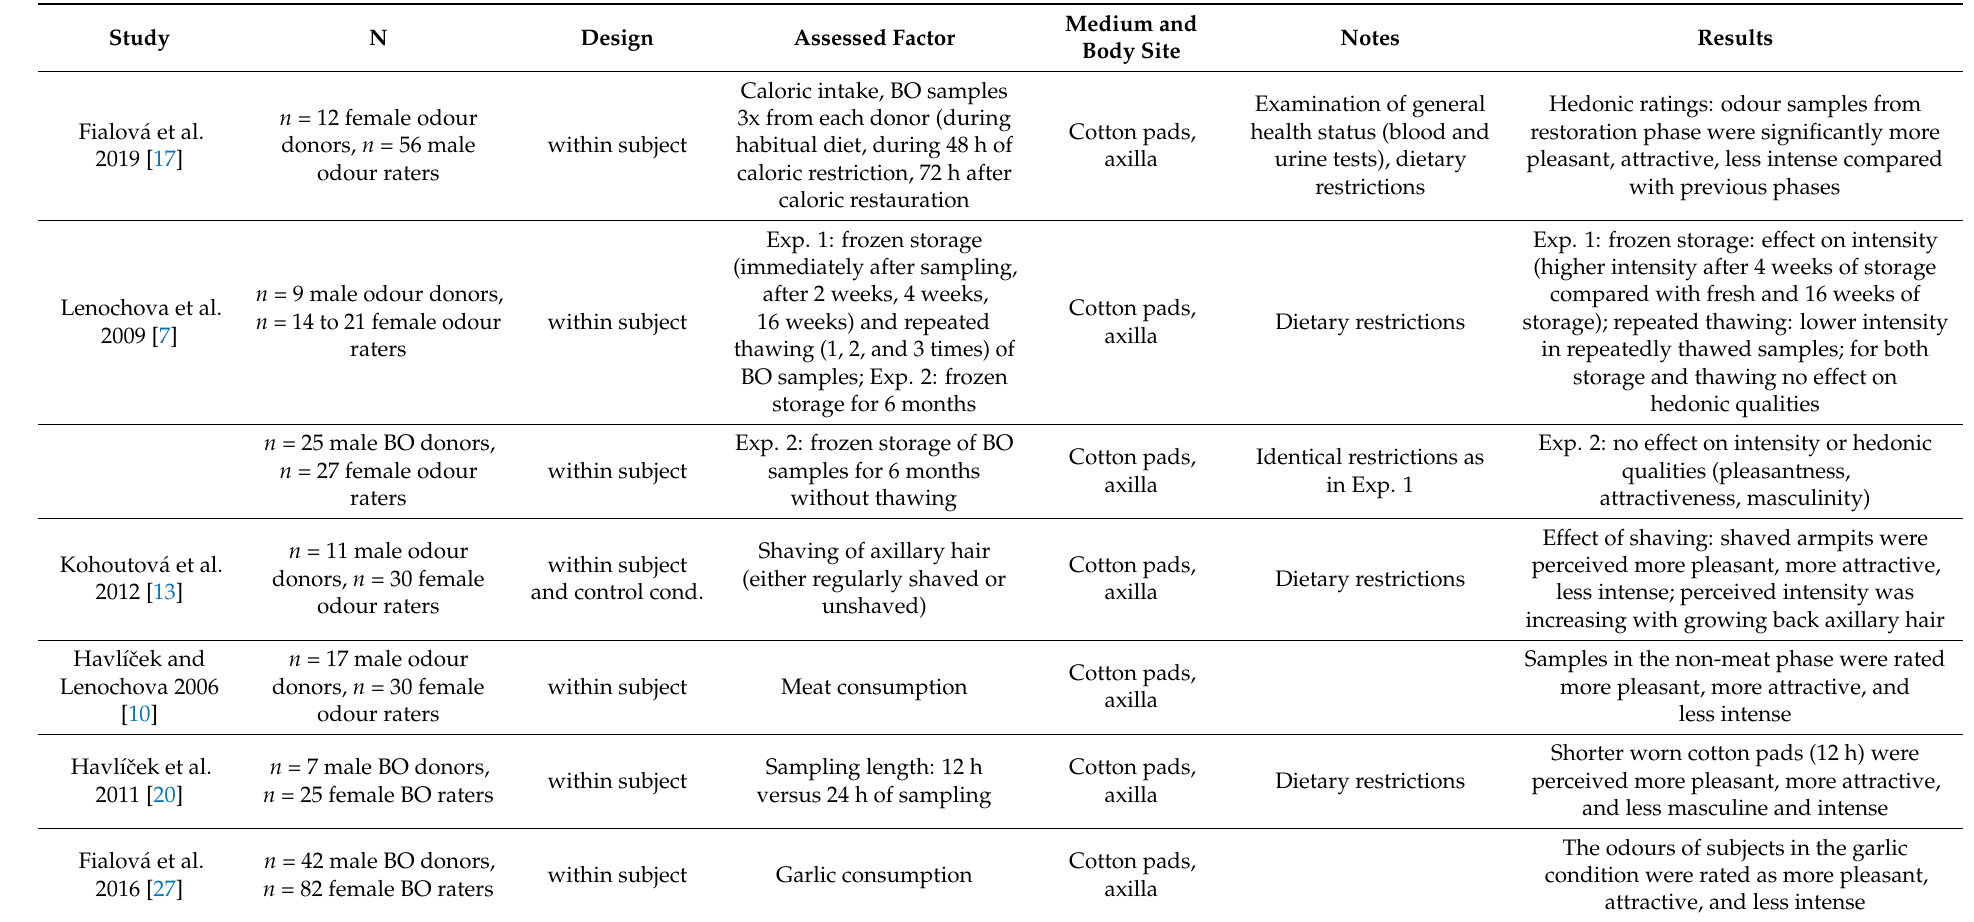
Table 1. Overview of methodological approaches to body odour